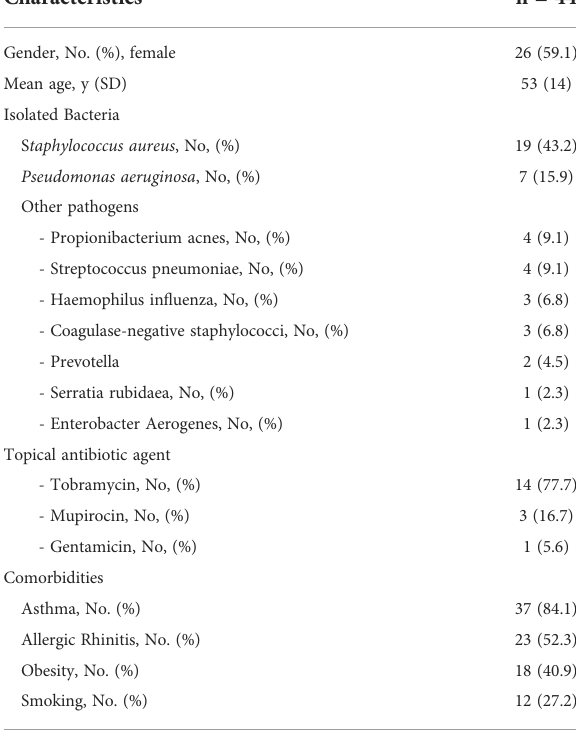
TABLE 1 Demographic and Clinical Data of the Study